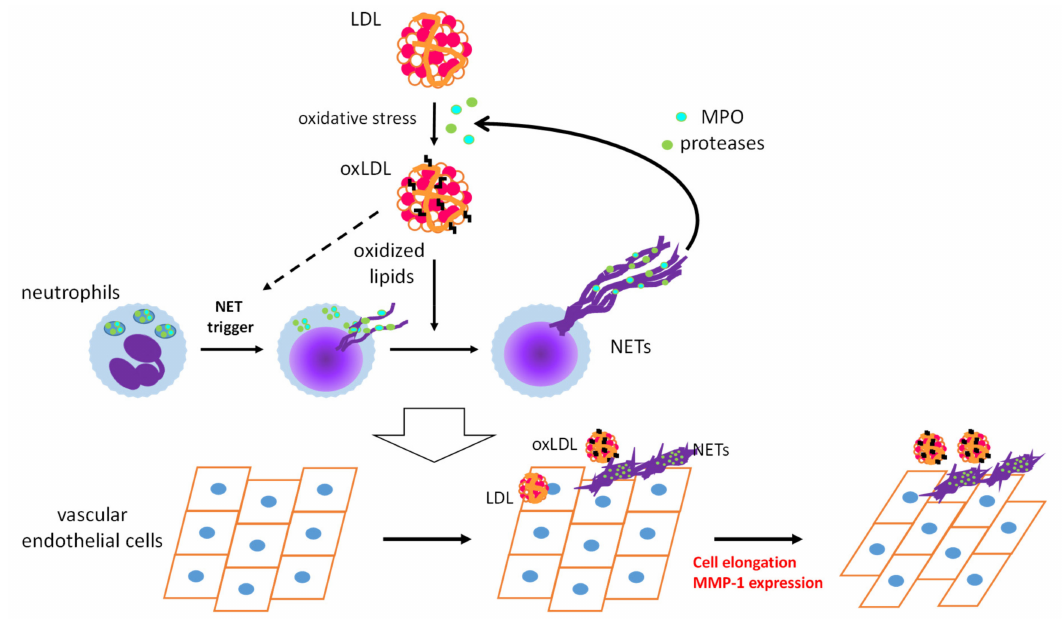
Figure 3. Schematic diagram of a feed-forward cascade that drives the neutrophil extracellular trap (NET)-induced endothelial inflammatory response. OxLDL strongly accelerates NET formation of activated neutrophils, while the same NET formation-inducing e ff ect of oxLDL on resting neutrophils has not been observed. MPO and proteases released from neutrophils by NET formation could act on native low-density lipoprotein (LDL) to facilitate modification of LDL. Coexistence of NETs and oxLDL or native LDL promotes endothelial inflammation to cause cell elongation and enhanced MMP-1 production in endothelial cells [119]. MPO: myeloperoxidase, MMP-1: matrix